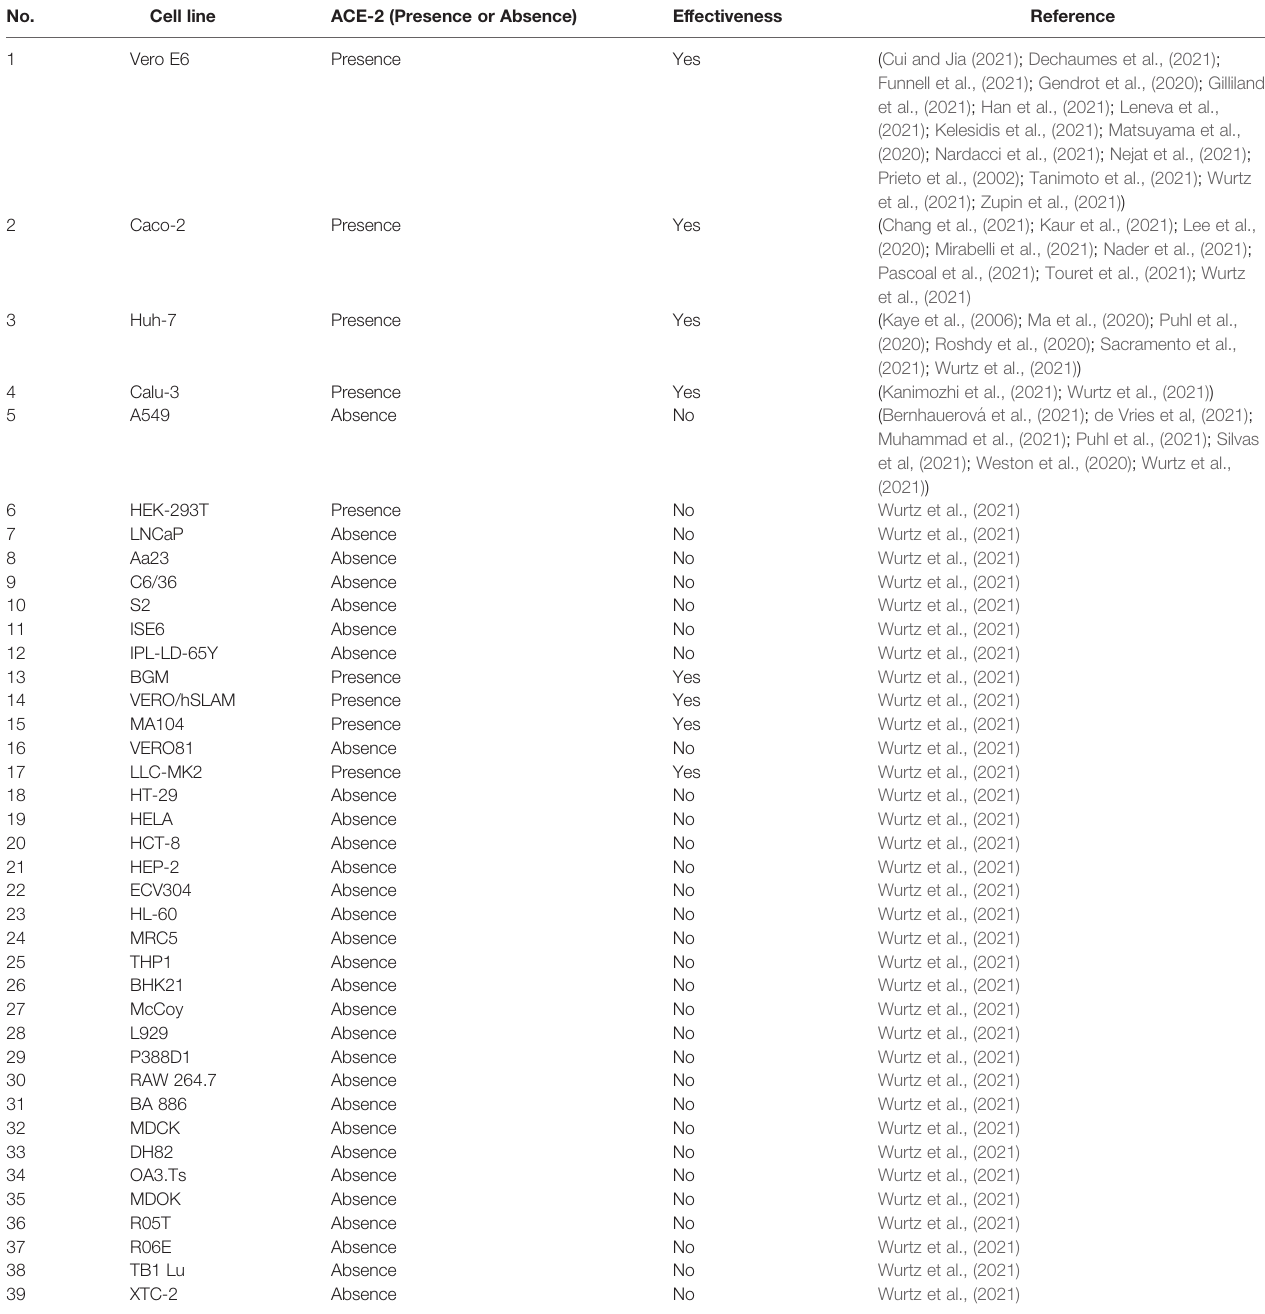
TABLE 1 | Cell lines susceptible to SARS-CoV-2 infection.